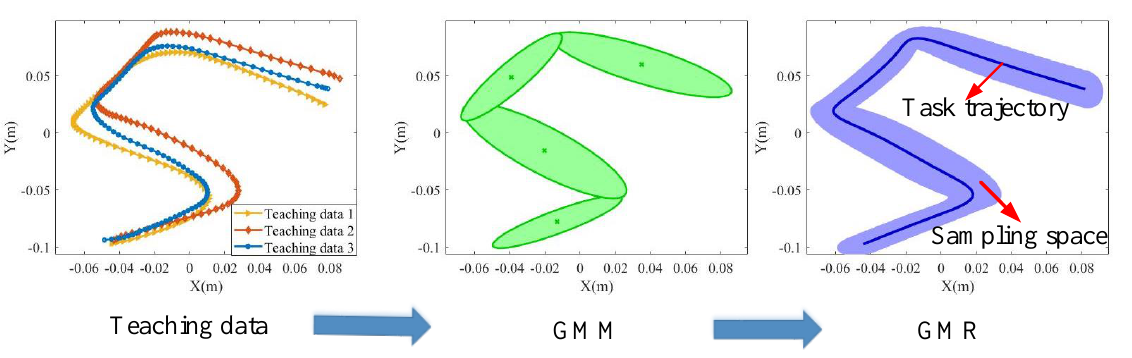
Figure 2. The GMM/GMR-MPRM path planning